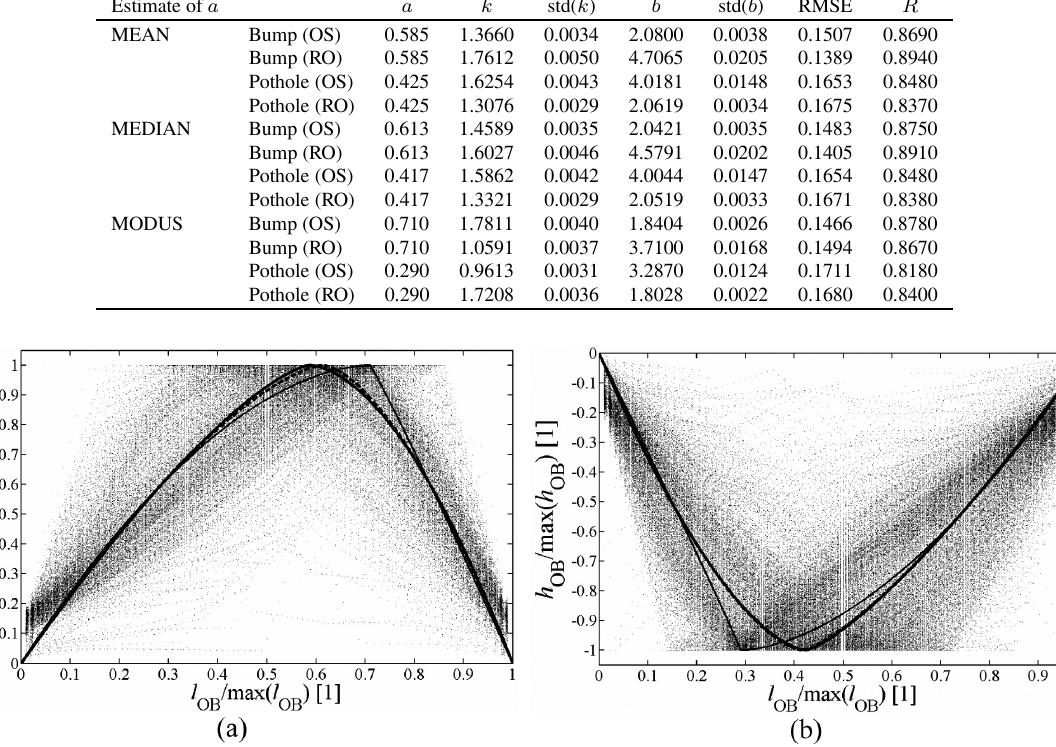
Fig. 6. Fitting of asymmetric obstacle shapes power( a ) separately for OS/RO branches: (a) CC + B; (b) CC + P, using estimates of a (mean ( ), median ( ), modus (